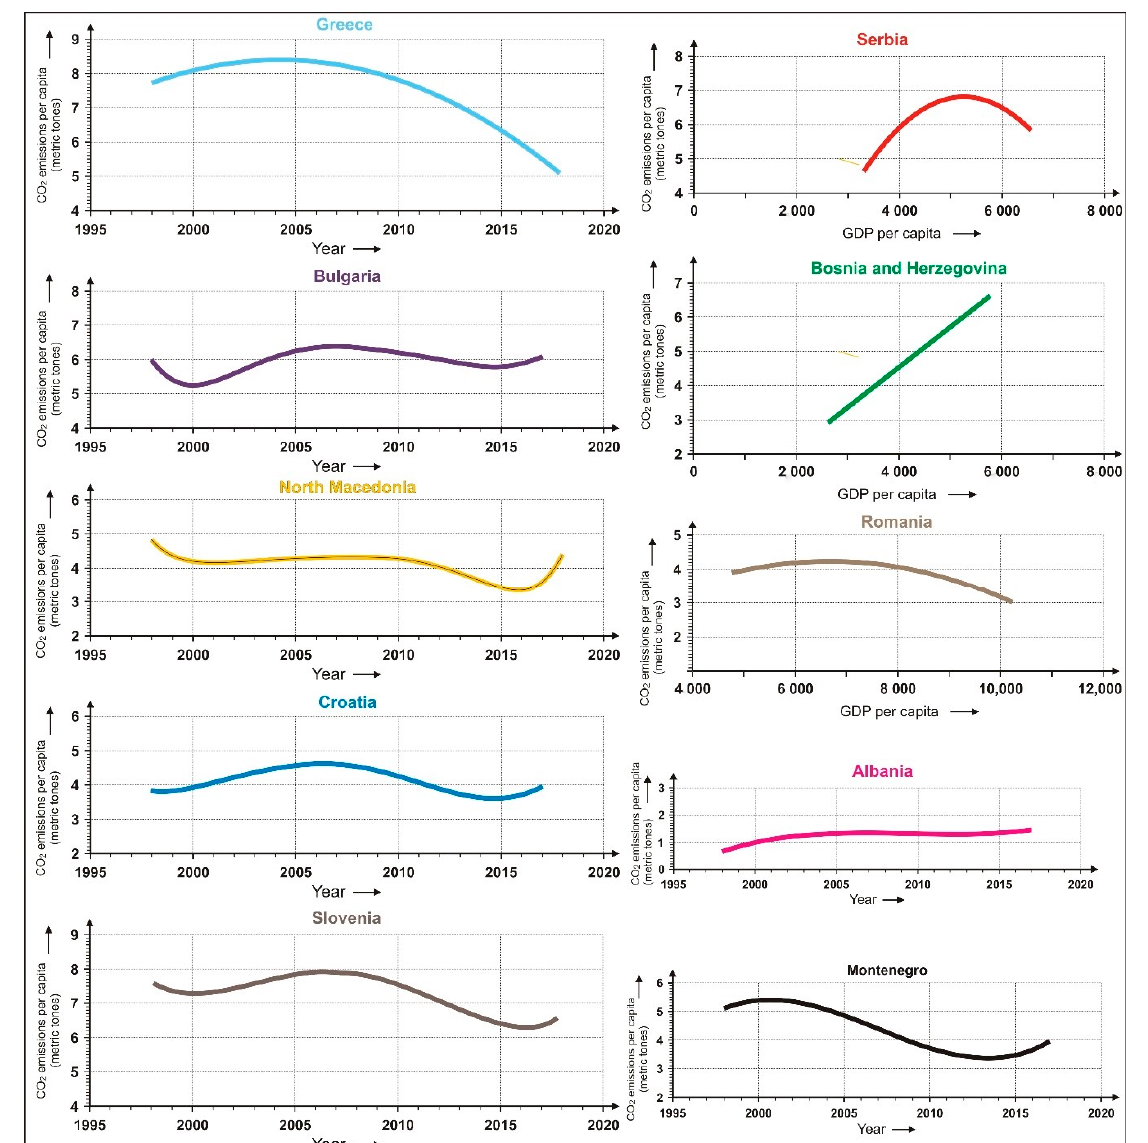
Figure A1. Relationship between CO 2 emissions per capita and GDP per capita in each of the ten Balkan countries (1998– 2019) (Authors’ creation).